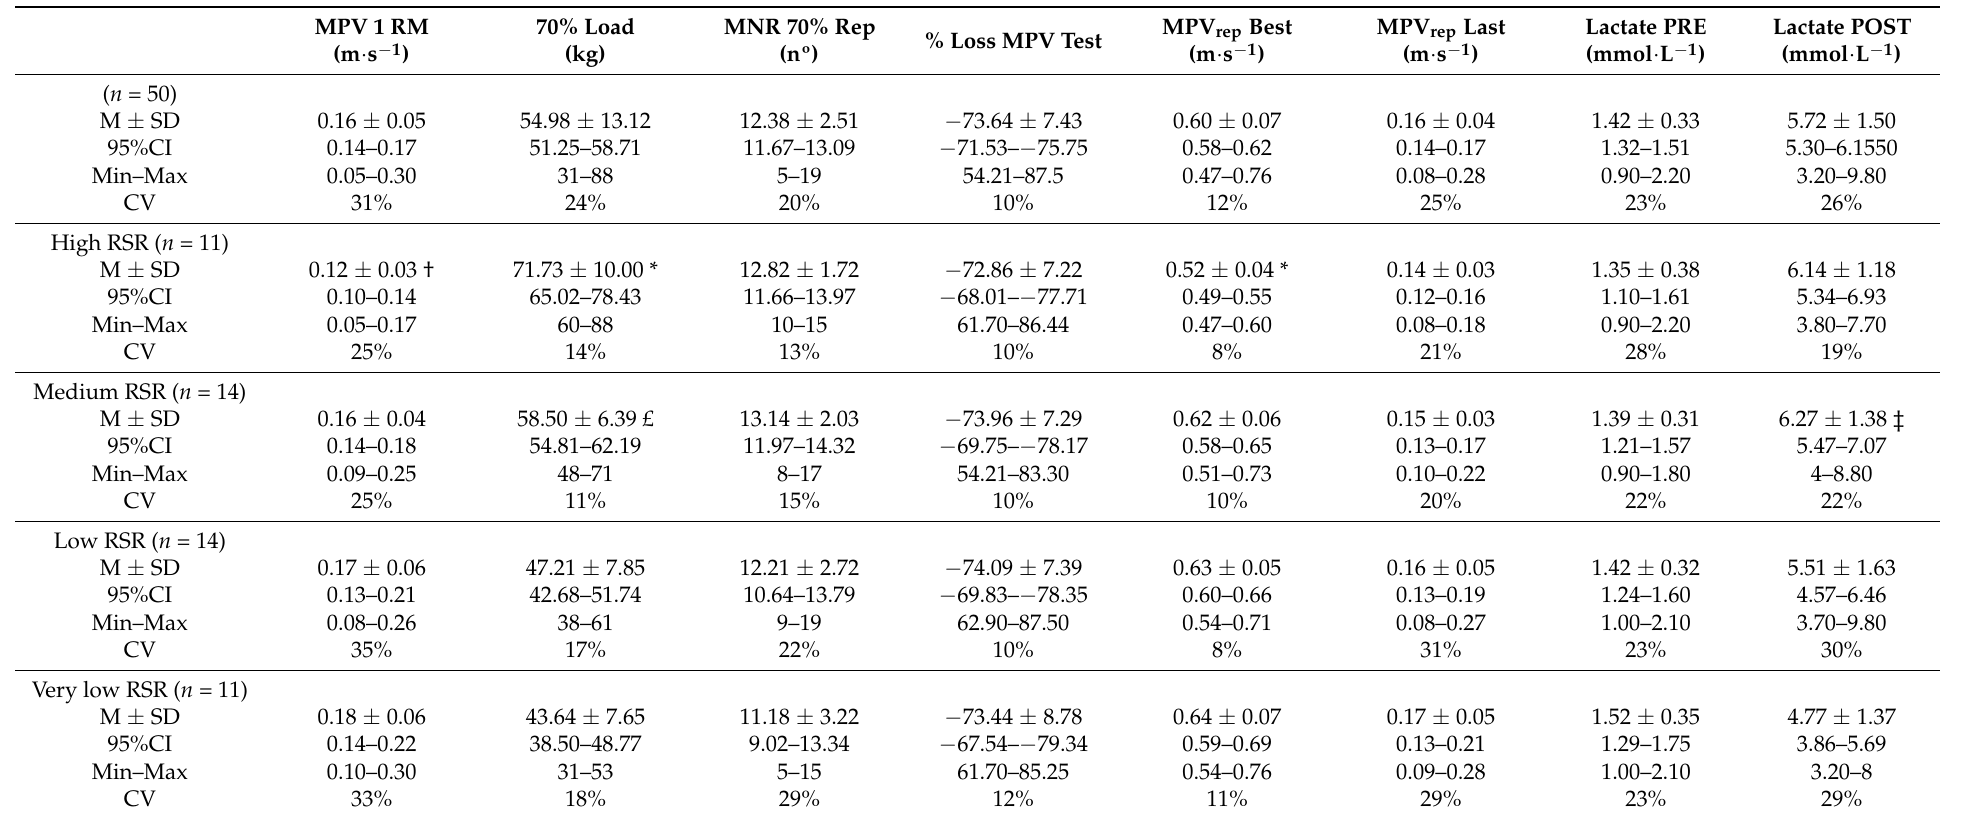
Table 1. Data were recorded from the test at a load of 70%